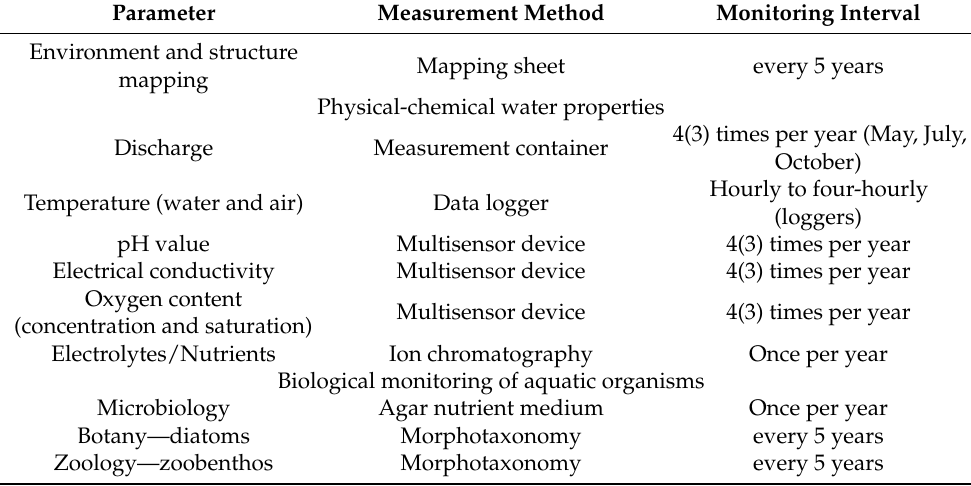
Table 1. Overview on monitoring